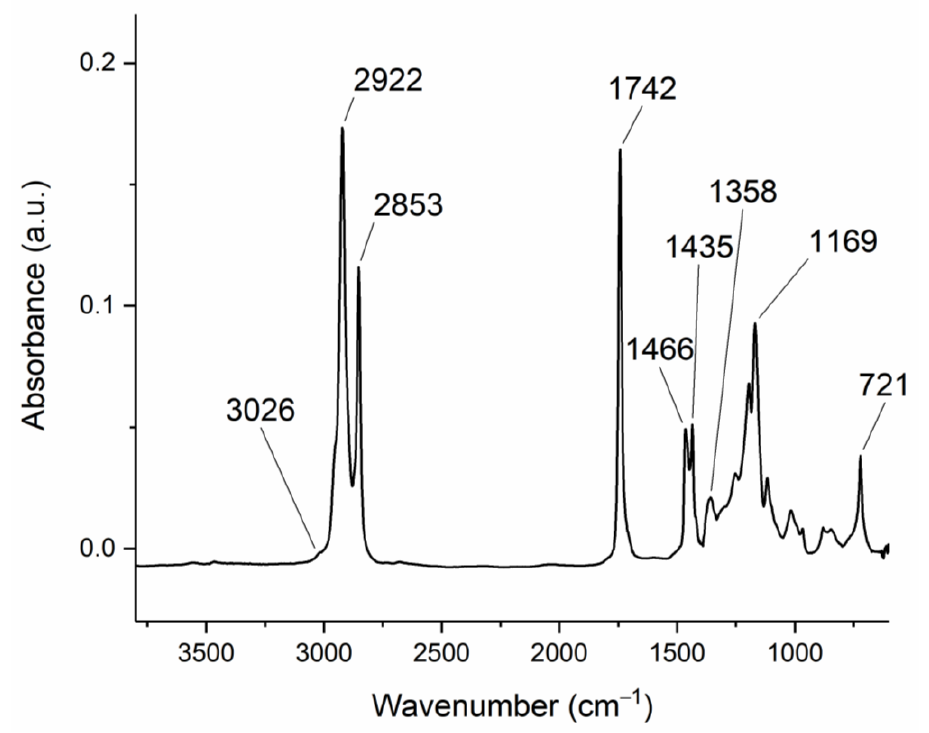
Figure 10. FT-IR spectrum for hydroformylated canola FAME product on the second methodology.